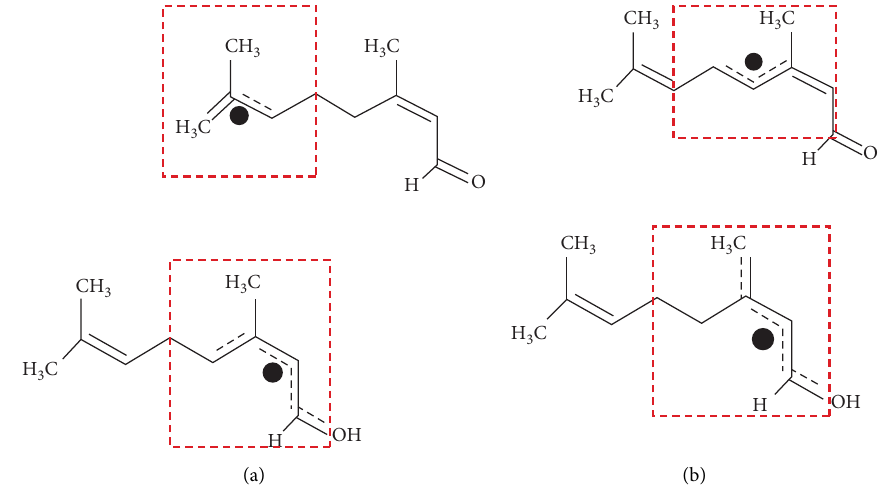
Figure 4: (a) Indication of allylic hydrogens in Nerol. (b) Possible antioxidant mechanism of nerol action in neutralizing R +